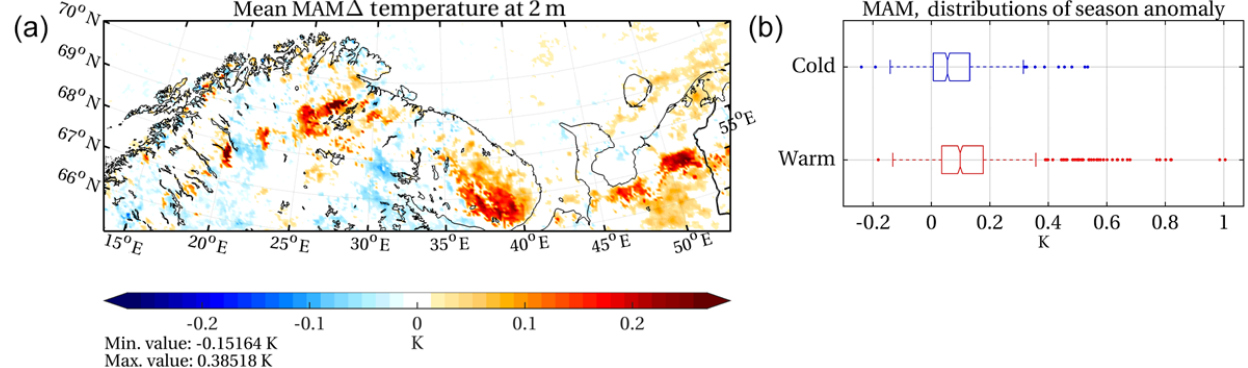
Figure 8. Difference in temperature response due to increased shrub cover (Veg0K–RefVeg) between the warm and cold years (only showing significant results at the 95% confidence level). The distributions of shrub-induced anomaly values are shown in box plots; the red box shows warm season anomalies and the blue box shows cold season anomalies in areas with vegetation